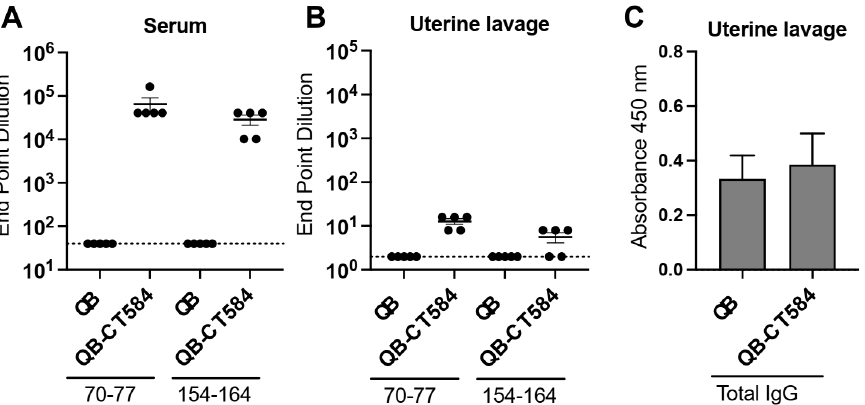
Figure 5. Vaccine epitope-specific antibody is detectable at low levels in uterine lavage. Serum ( A ) and lavage of the lumen of the uterus ( B , C ) was collected from mice immunized with either Q β -CT584 or the negative control Q β alone. ( A , B ) IgG specific to vaccine epitopes CT584 70–77 and CT584 154–164 was measured by ELISA. End point dilution was defined as the reciprocal of the highest sample dilution with an OD450 reading twice that of blank wells. Antigen-specific IgG was detectable in uterine lavage ( B ) but at lower levels than in serum ( A ). ( C ) The amount of total IgG in uterine lavage was comparable between the two vaccination